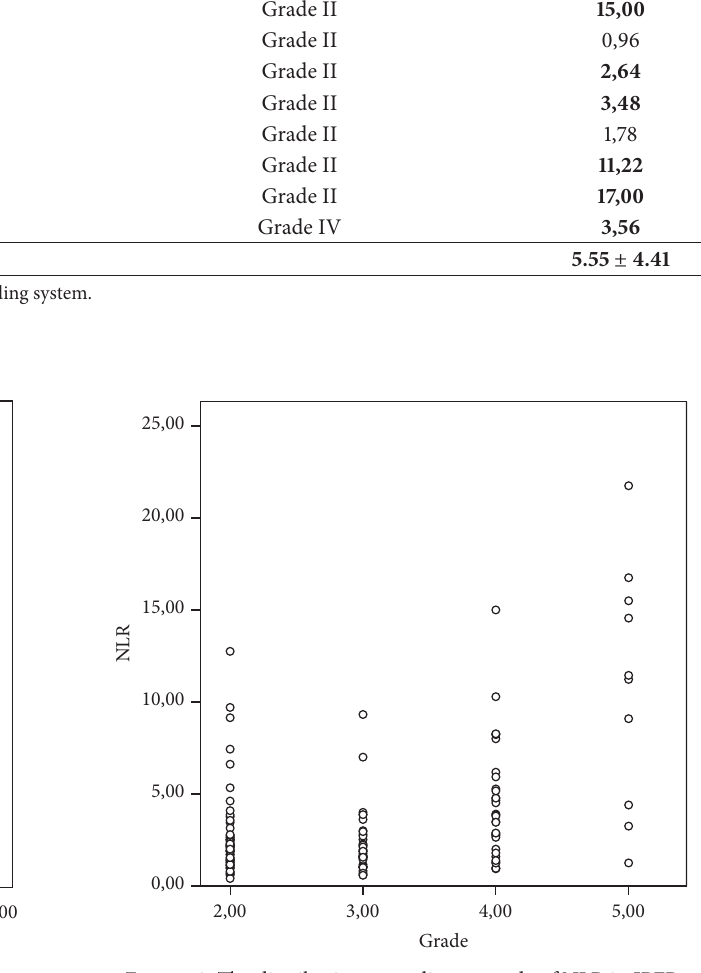
Figure 2: The distribution according to grade of NLR in